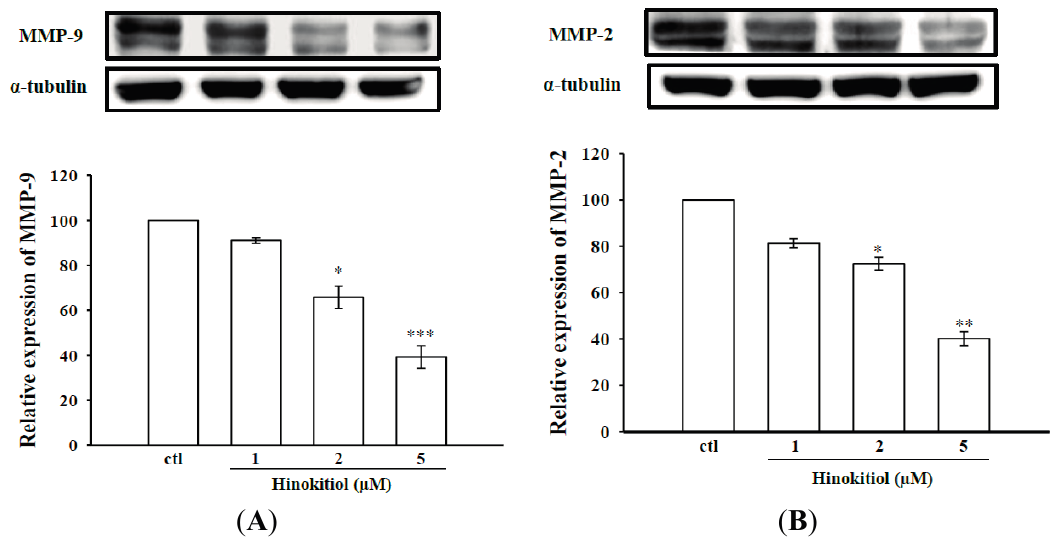
Figure 1. Effects of hinokitiol on MMPs-9 and -2 expression and in B16-F10 melanoma cells. B16-F10 melanoma cells were treated with different doses of hinokitiol (1–5 µM) in serum-free media for 24 h. Cell lysates were obtained to detect the MMP-9 ( A ) and MMP-2 ( B ) proteins expression using Western blotting. The figures are representative examples of three independent experiments. * Indicates the values are significantly different from the